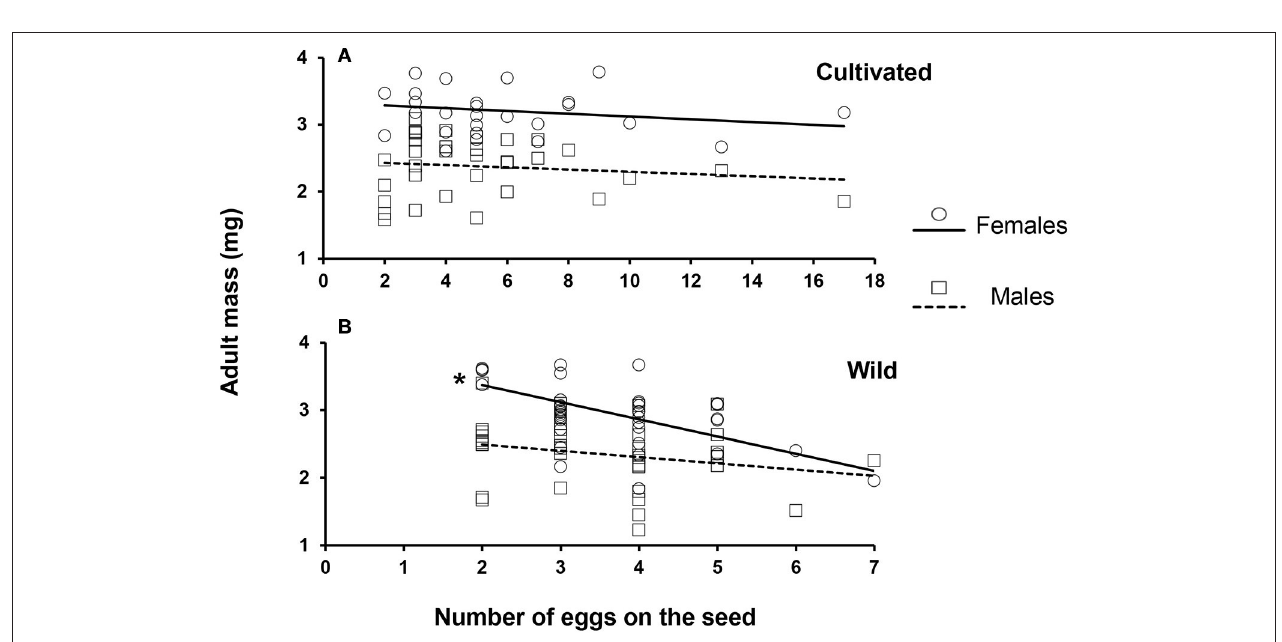
FIGURE 5 | Correlation between the weight of adult females (circles) and males (squares) that emerged from (A) domesticated and (B) wild seeds carrying different egg densities (as a proxy of the intensity of larval competition inside the seed). Solid lines indicate linear regression for female beetles and dashed lines show linear regression for males. A significant correlation was found for females emerging from wild seeds ( N = 39, Spearman r = − 0.48, P = 0.002; non on cultivated seeds P = 0.34) whereas, for the males no significant correlation was found ( P = 0.056 wild seeds; P = 0.9 cultivated seeds). *Indicates significant difference p < 0.05.